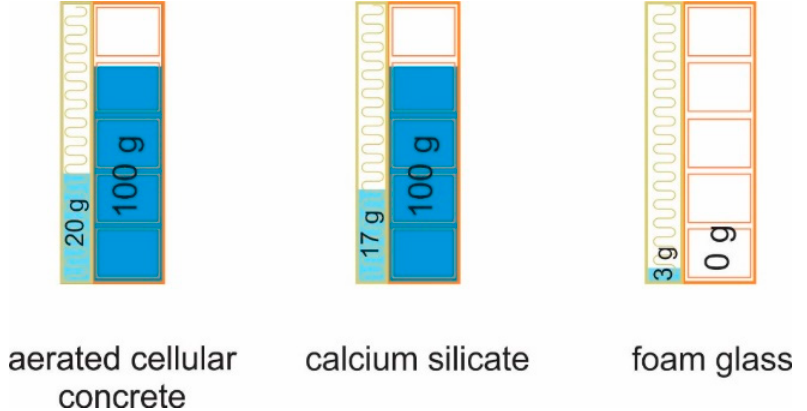
Figure 5. The increase in the mass of different insulation layers (left on each figure) and original wall (right) after 10 days of a hot box–cold box experiment.